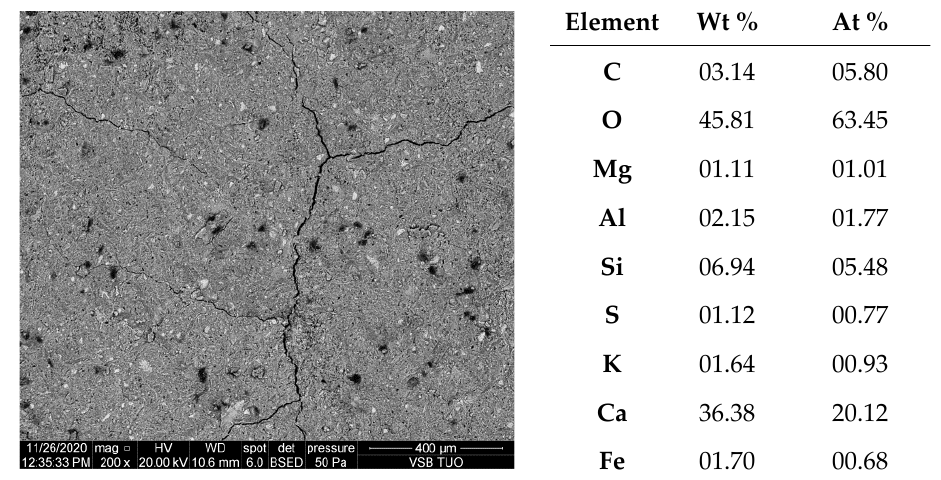
Figure 4. SEM image of the microarea of C.I.3 specimen with its elemental composition, by weight — (Wt) and atomic proportions — (At).